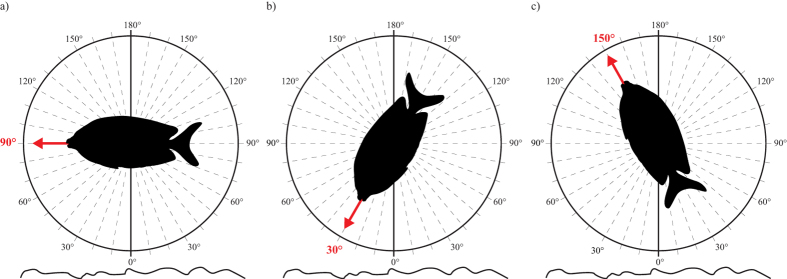
Schematic description of the assessment of angles exhibited by rabbitfishes.Angles were assessed based on a vertical line perpendicular to the substratum using a protractor superimposed on the screen. 90° denotes a horizontal position parallel to the substratum (a), while 30° mark a head-down position (b), and 150° mark a head-up position (c). The head-up position (ranging from ~90° to 180°) was identified as a vigilance position. Illustrations are original drawings by Simon J. Brandl.